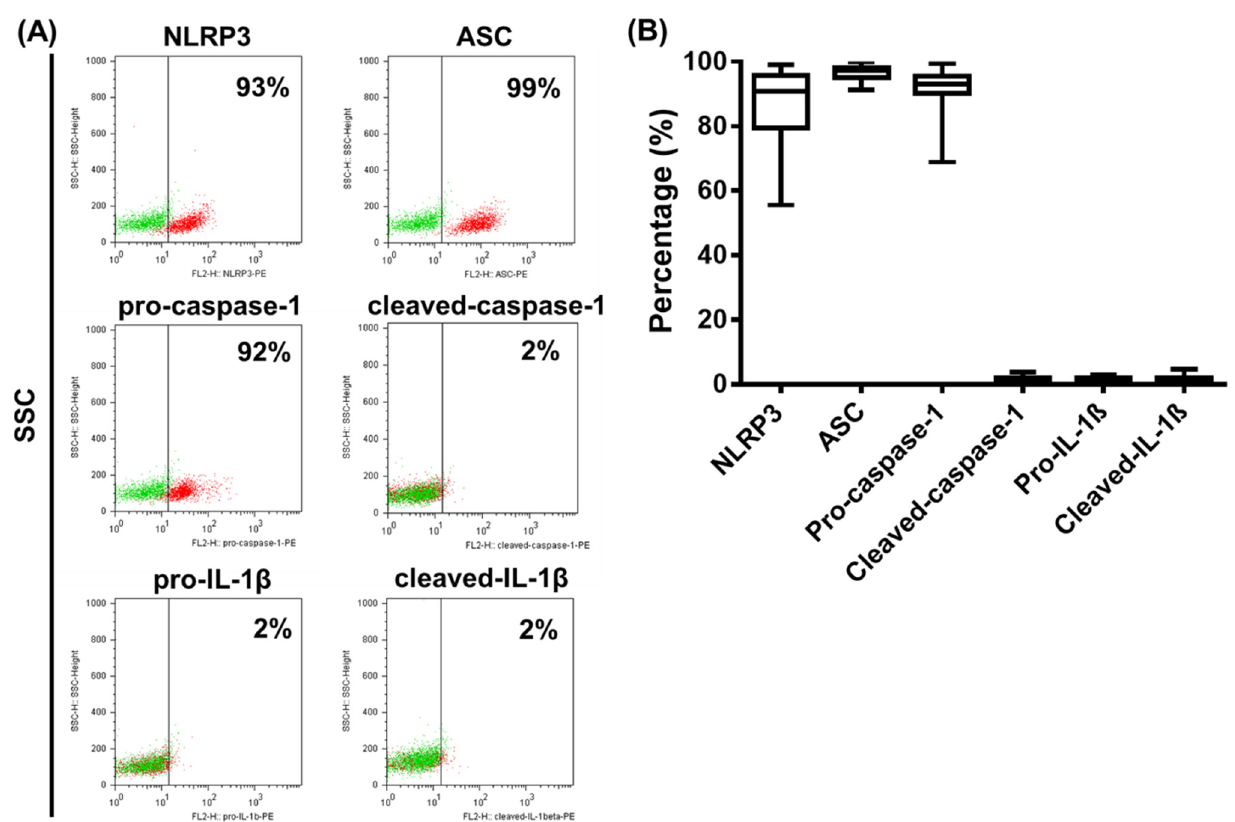
Figure 4. The baseline expression of NLRP3 inflammasome pathway components in primary human pDCs. The NLRP3, ASC, pro-caspase-1, cleaved caspase-1, pro-IL-1 β and cleaved IL-1 β expressions in primary human pDCs gated from PBMCs were measured using intracellular flow cytometry. Representative dot plots are shown in ( A ). Green dots indicate isotype controls and red dots show the specific proteins (A). Data are represented as mean ± SD of 22 individual experiments and analyzed using one-way ANOVA followed by Bonferroni’s post-hoc test ( B ). SSC: side scatter.